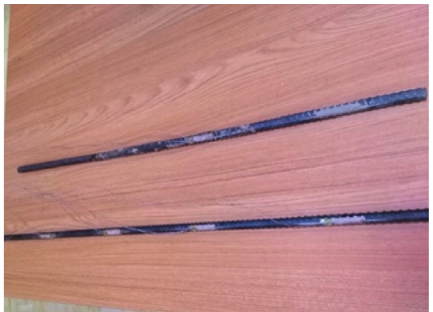
5: Test anchor with pasted strain gauges (HRB335, diameter � 12